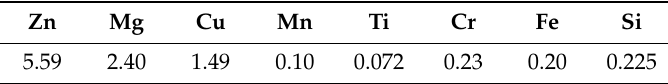
Table 1. Chemical compositions of 7075-T6 (wt %).